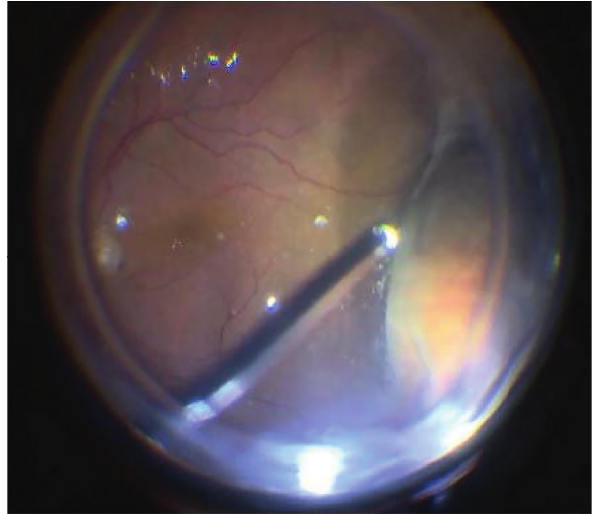
Figure 4: Complete vitrectomy: peripheral vitreous removal with vitreous base shaving using dynamic preequatorial scleral indentation.